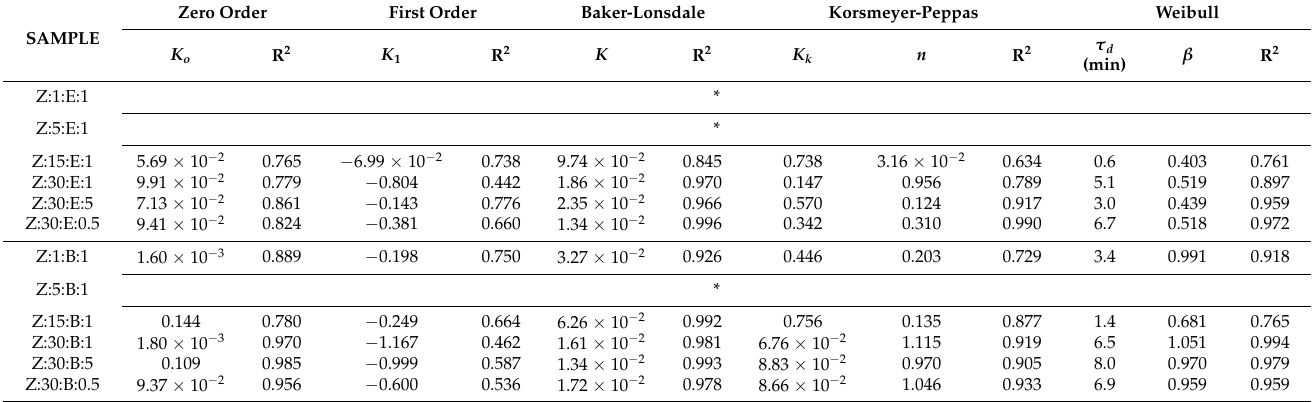
Table 1. Parameters and correlation coefficients of each equation from the kinetic models of the zein microstructures loaded with EGCG or VitB12. Samples marked with * was not possible to fit any model due to the fast core release.